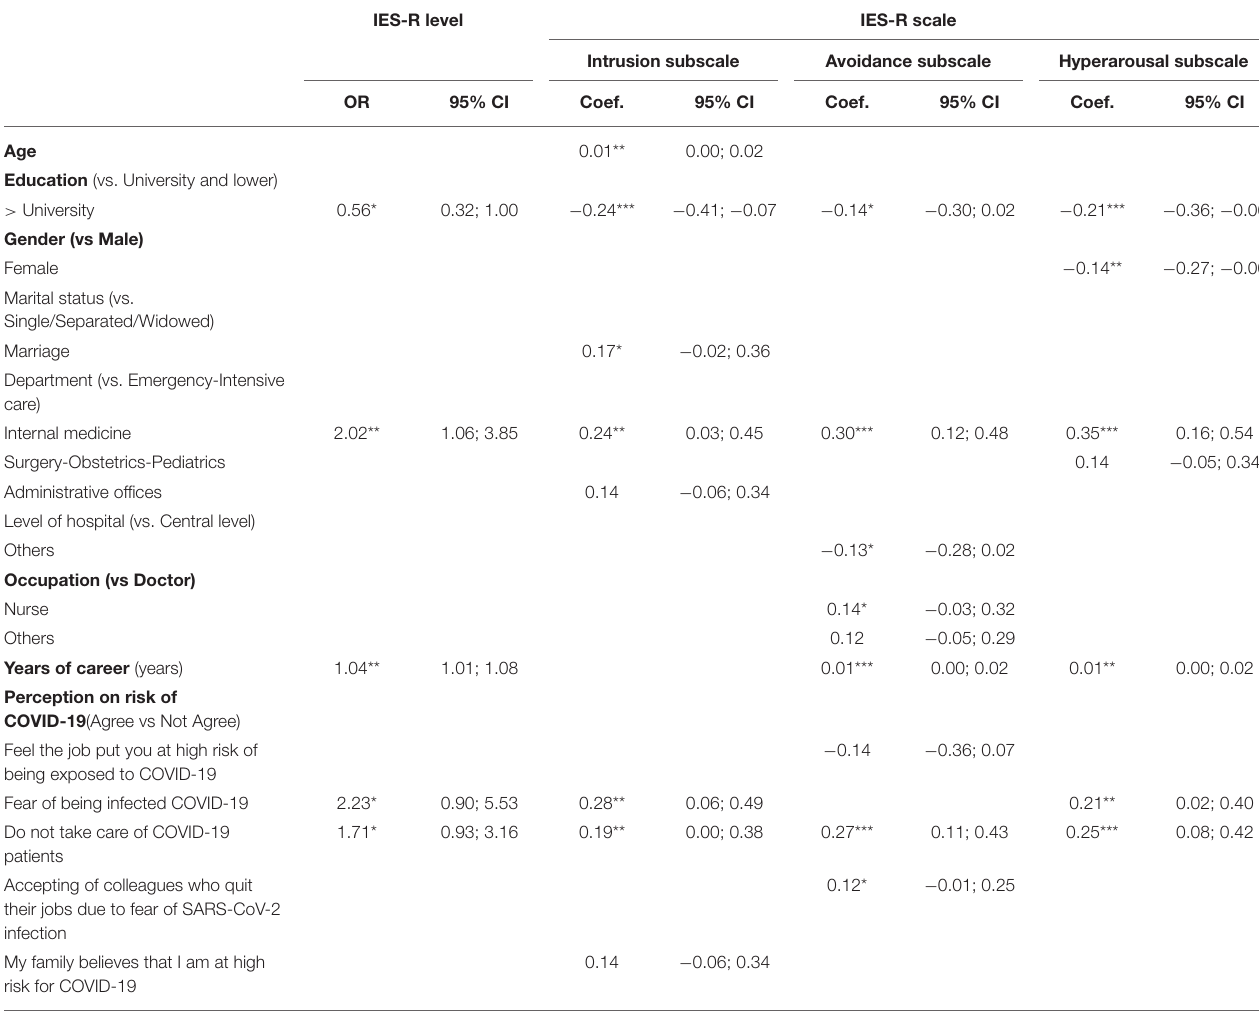
TABLE 3 | Associated factors of psychological and social impacts of